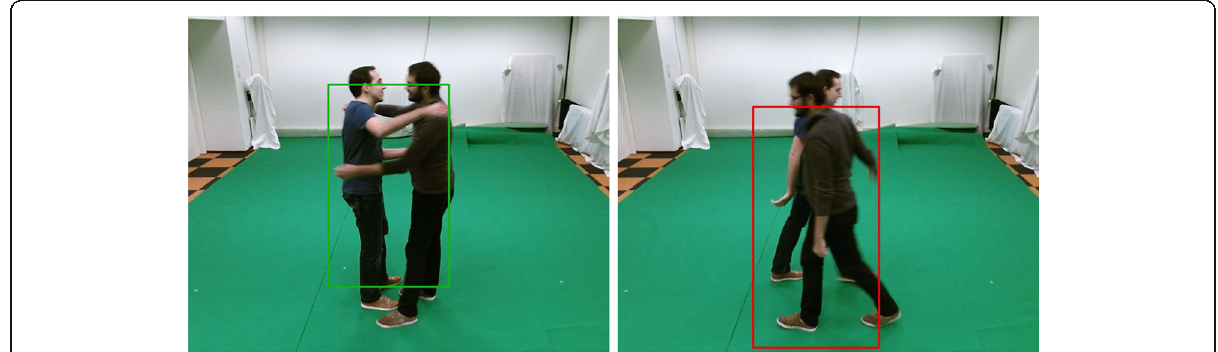
Fig. 8 True positive hug localization (score 0.94) (left). False positive localization of a hug with two persons about to cross each other after a distractor interaction (score 0.36) (right)